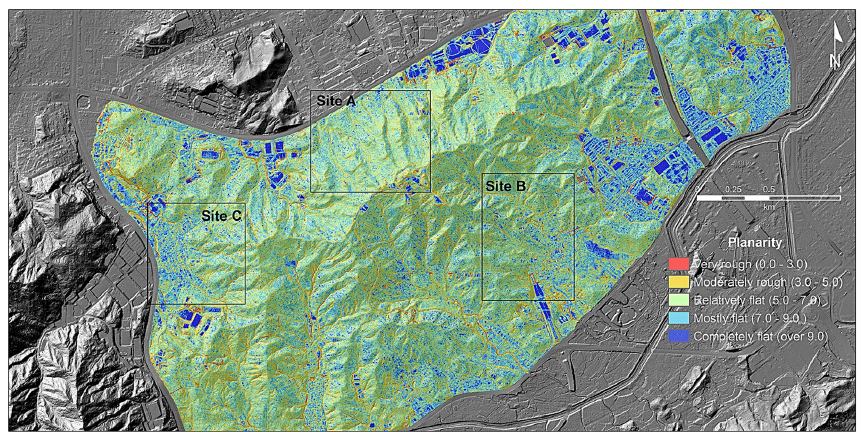
Figure 8. Spatial distribution of the planarity over the effective study area. Areas outlined by black rectangles are shown in Figs. 10 to